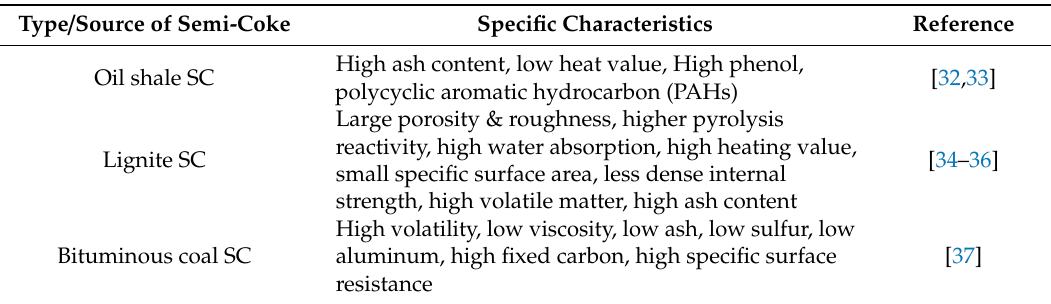
Table 2. Characteristics of some semi-coke.